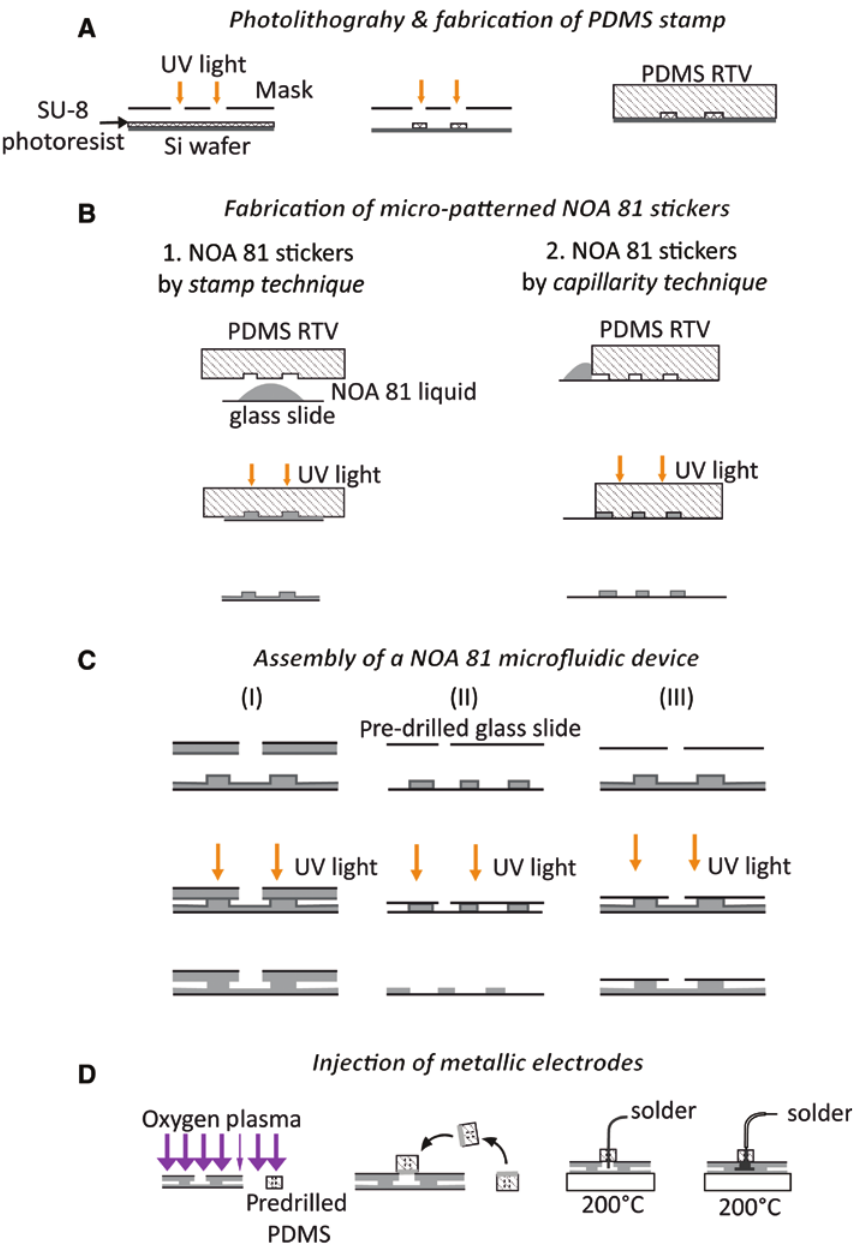
Figure 1: Fabrication steps of a plasma microreactor with solidified electrodes. (A) Photolithography and fabrication of PDMS stamp; (B) fabrication of micro-patterned NOA 81 stickers; (C) assembly of a NOA 81 microfluidic device; (D) injection of metallic